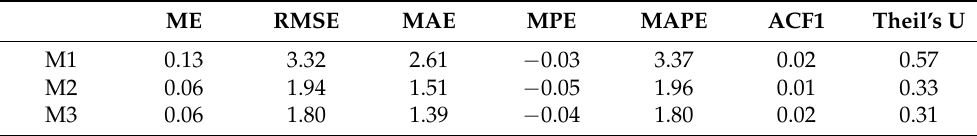
Table 3. Insomnia’s hybrid model accuracy measures.